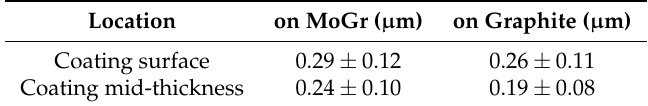
Figure 28. FIB cross-sections on Mo-coated samples produced on graphite ( a ) and on MoGr ( b ) substrates with HIPIMS. The contrast between grains is due to the electron channeling effect. Vertical lines are due to the FIB process. Table 9. In-plane grain size of the coating cross-sections (average ± standard deviation) from image analysis of Figure